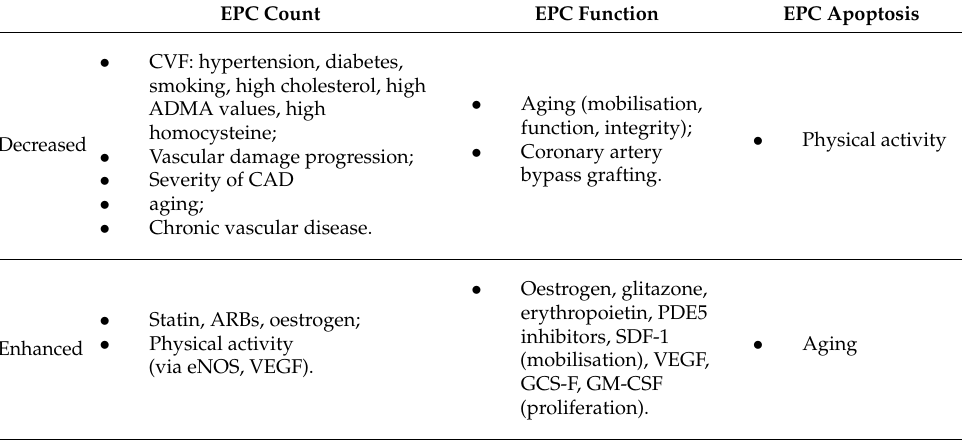
Table 1. Correlations of EPC count, EPC function and EPC apoptosis with cardiovascular risk and protective factors, pathophysiologic state, physiologic mediators and common drugs in cardiovascu- lar